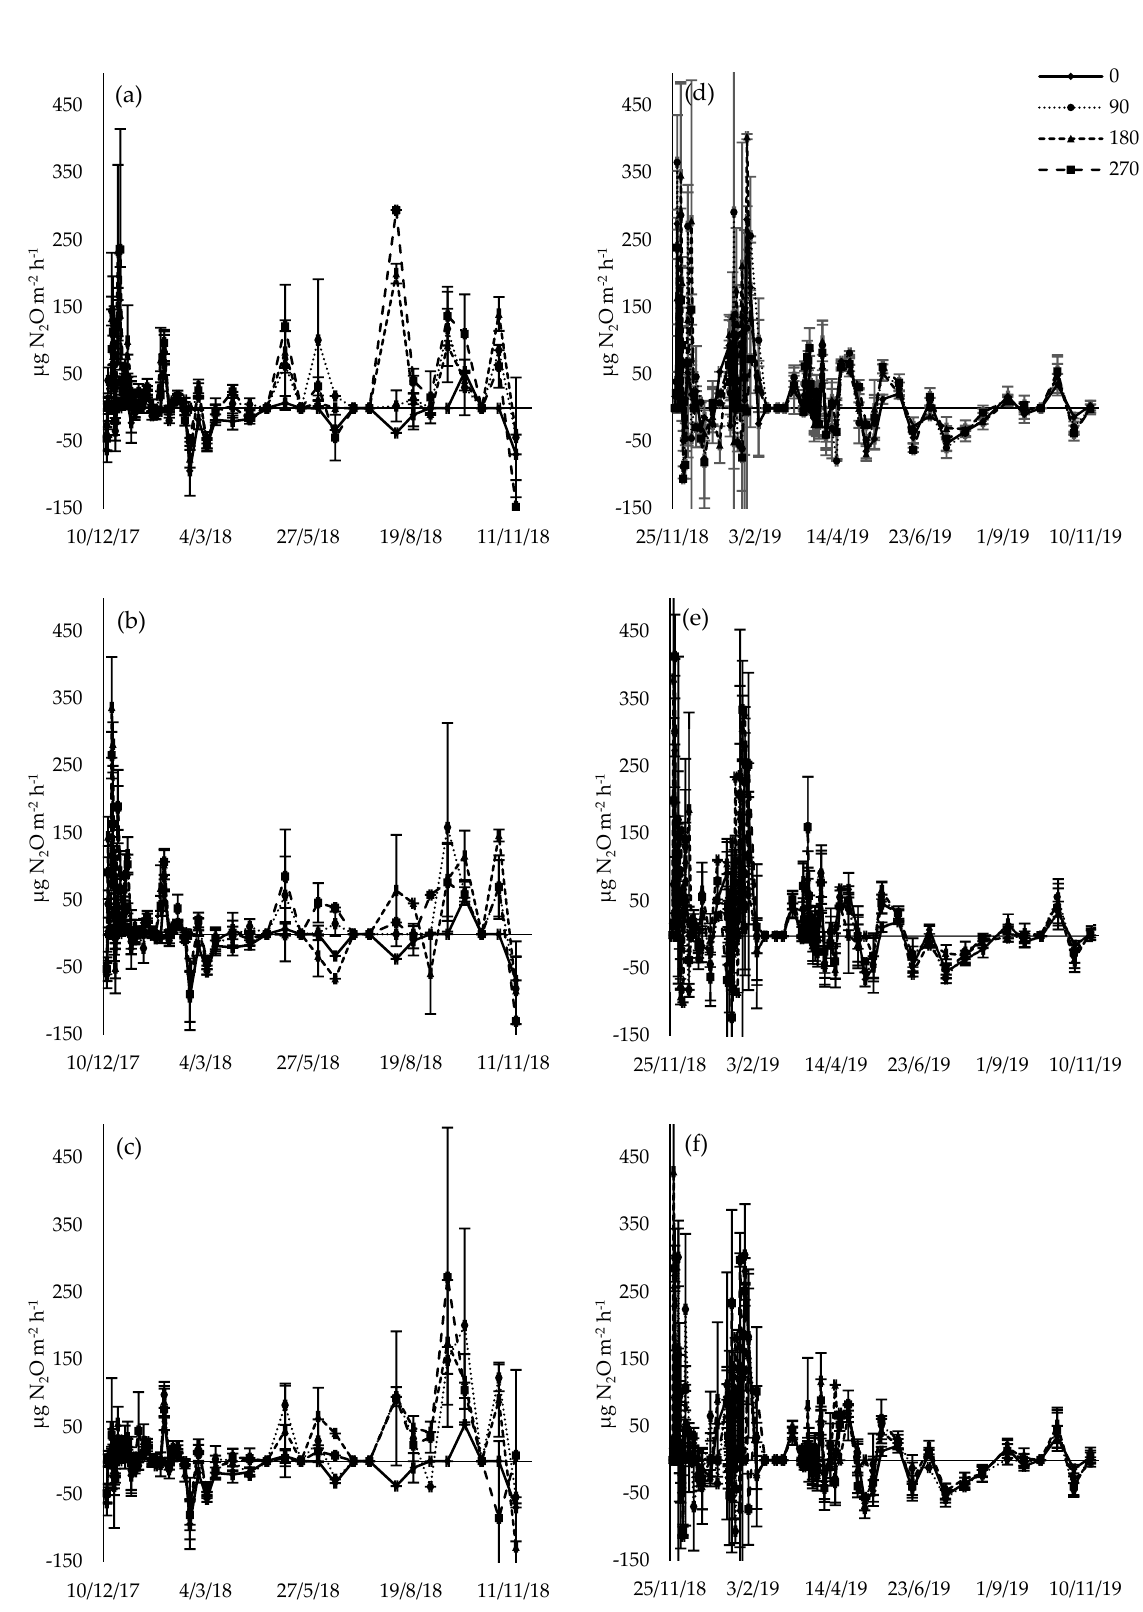
Figure 5. Descriptive averages of N 2 O fluxes ( µ g m − 2 h − 1 ) from pastures managed with N fertilizers in two experiments. ( a ) Urea, ( b ) ammonium nitrate, and ( c ) ammonium sulfate in experiment 1. ( d ) Urea, ( e ) ammonium nitrate, and ( f ) ammonium sulfate in experiment 2.